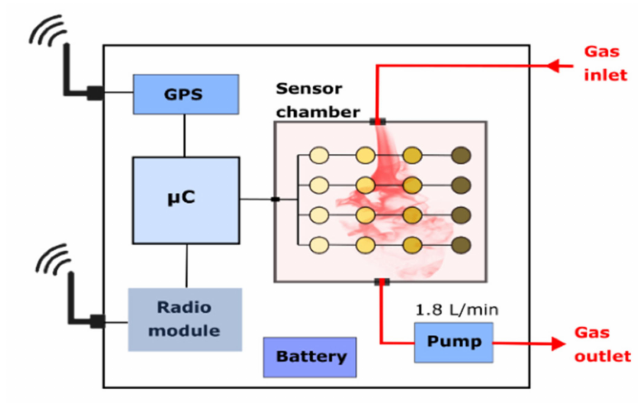
Figure 3. Internal architecture of the electronic